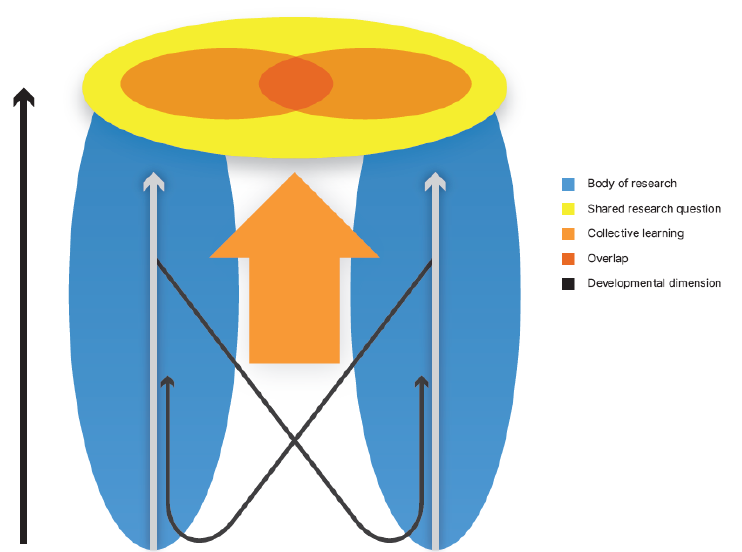
Figure 1. Two bodies of research addressing a shared research question. Illustration by Emily Laneryd Fujiwara. The arrow on the left is a general developmental dimension as indicated in the legend. The two thinner black arrows indicate a developmental dimension of the individual.